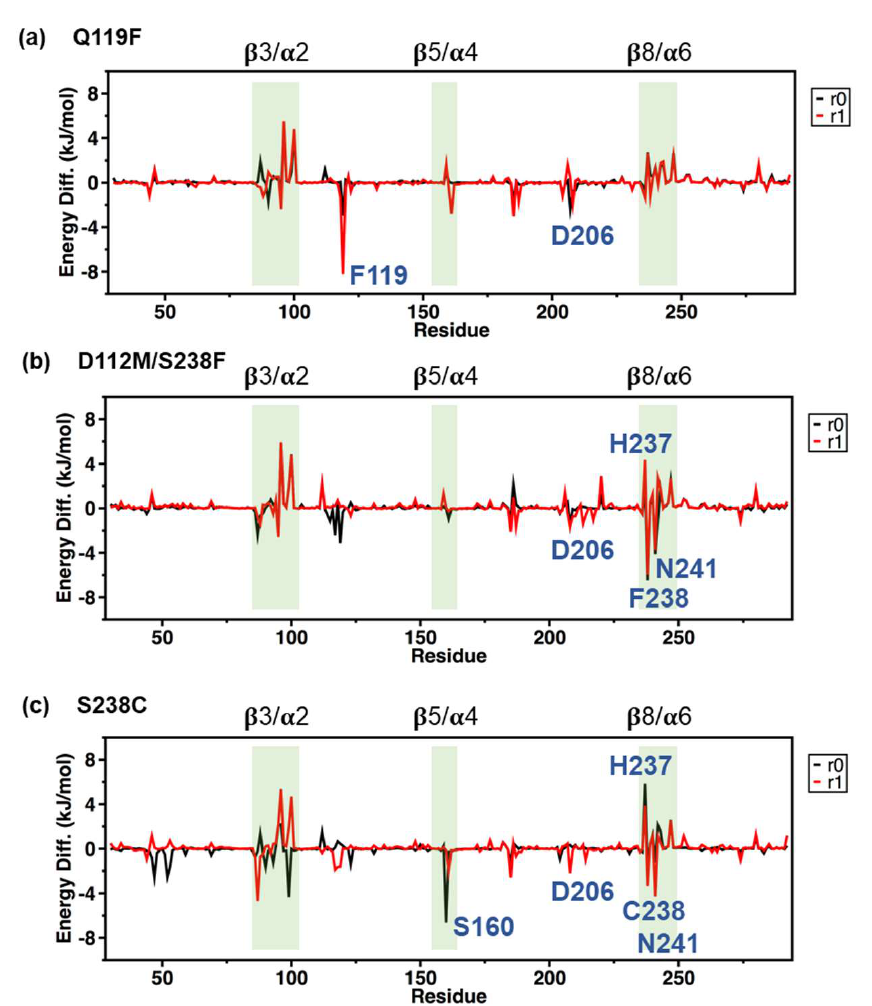
Figure 8. MM/PBSA analysis. The differences of per-residue MM/PBSA binding free energy decomposition of ( a ) Q119F, ( b ) D112M/S238F, and ( c ) S238C complexes relative to the WT complex were shown in two replicas (“r0”—black line and “r1”—red line). Important peaks at regions β 3/ α 2, β 7/ α 5, and β 8/ α 6 were highlighted in green.